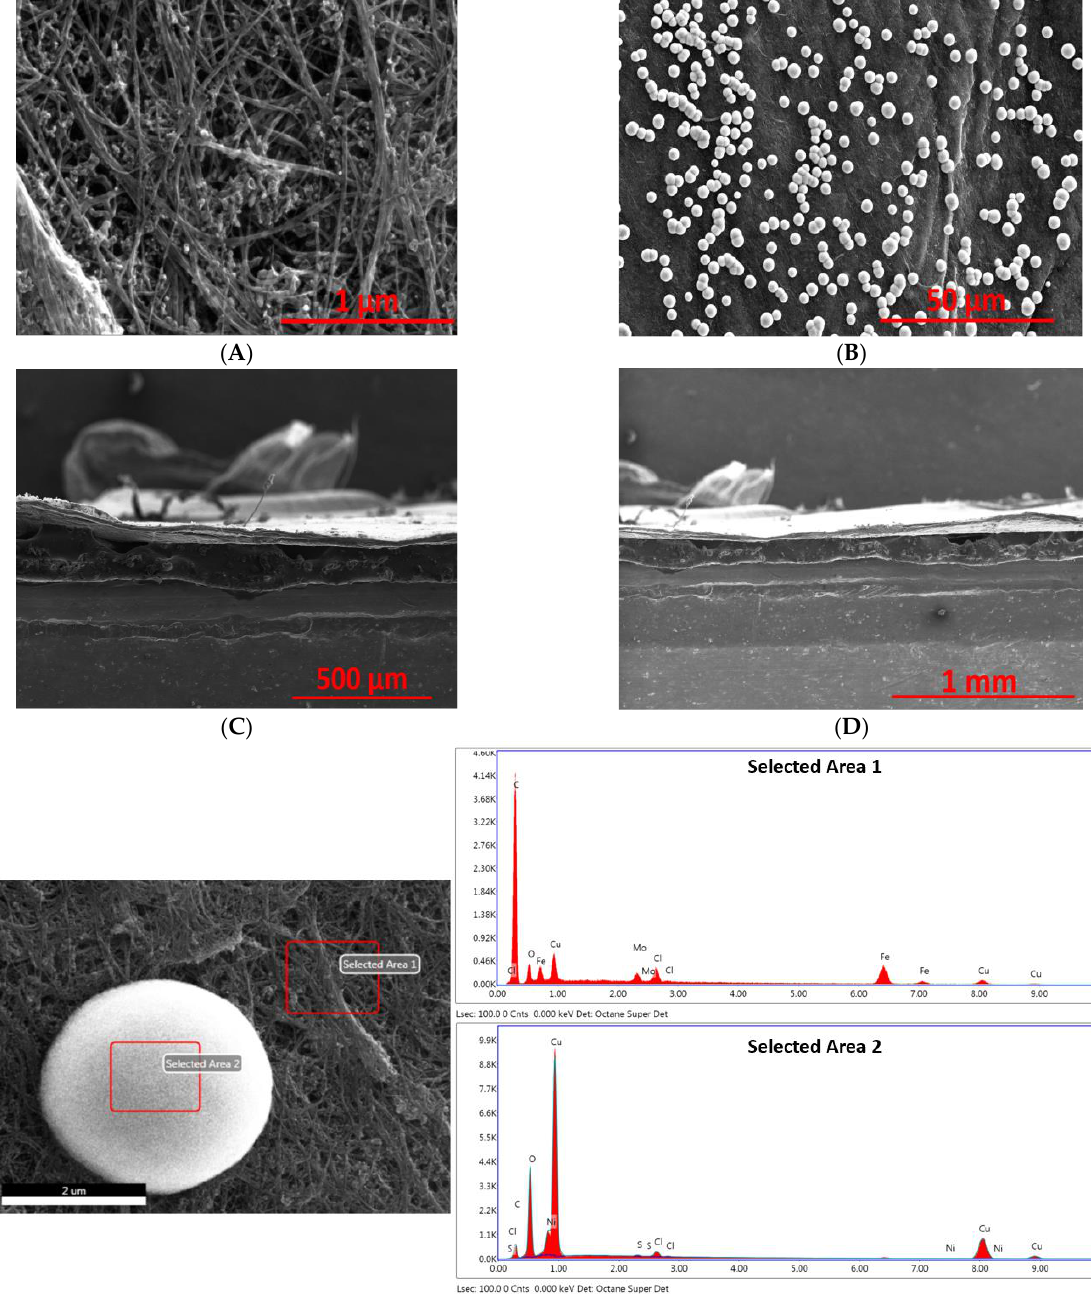
Figure 3. SEM images of acid-treated CNT with Cu organic deposition: surface morphology ( A , B ), as well as cross-sectional images ( C , D ), and EDX spectrum of the selected area ( E ). In terms of the activated CNT sheet, due to the nature of the electrochemical activa- tion process, which generates a copious amount of H 2 , H 2 is not only able to delaminate the CNT sheet, but surface roughness has also been increased due to the bulge formation in the CNT sheet from H 2 generation. The distance between CNT strands appears to be winder that of non-activated ones (Figure 4A), the rough surface also gives rise to the rough Cu surface morphologies (Figure 4B). Past literature has shown that surface